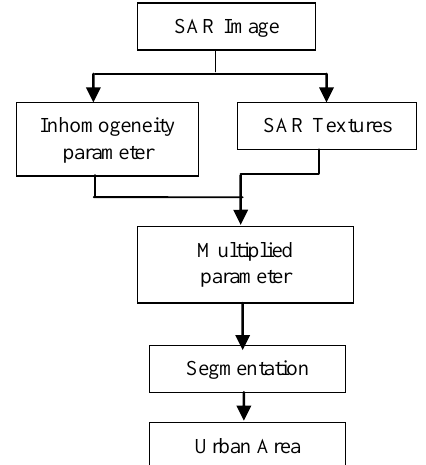
Fig.1 Flowchart of the implemented